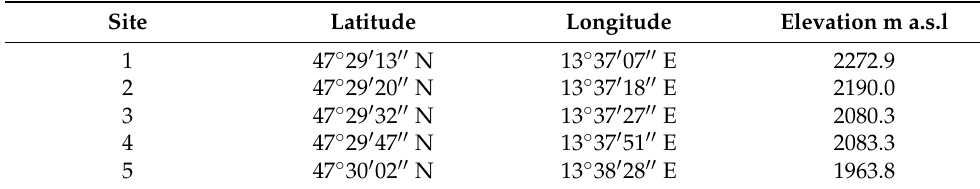
Table 1. Position of centrally located rock surfaces within each test site.